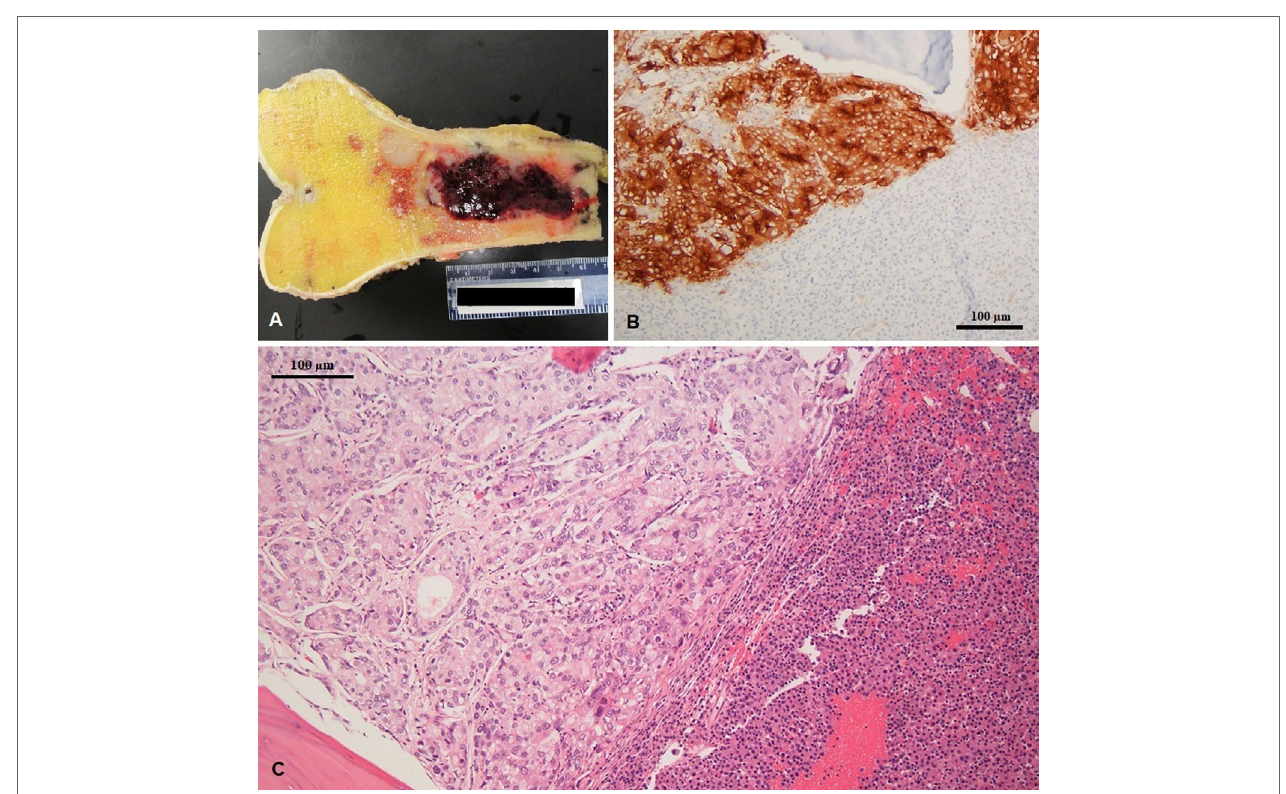
FIgURe 4 | (a) Excised left femur with hemorrhagic tumor involving the diaphysis (gross specimen), (B) prostatic specific membrane antigen expression in prostate adenocarcinoma (left) and negative in multiple myeloma (right), and (C) coexisting metastatic prostate adenocarcinoma and multiple myeloma in same histologic section; note the gland forming adenocarcinoma (left) and sheets of plasma cell infiltration